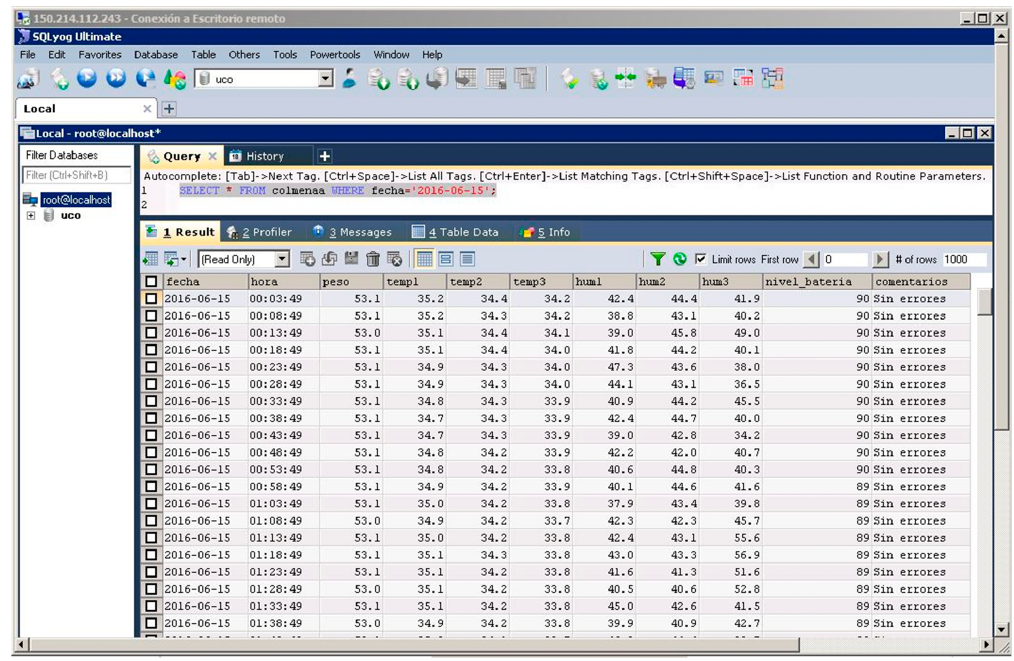
Figure 7. View of a query to the cloud database server.